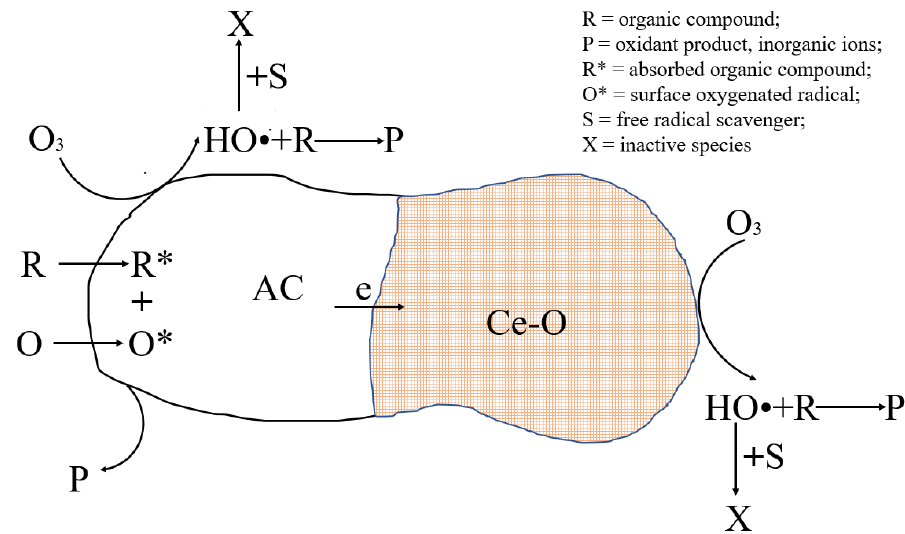
Figure 1. Illustrative representation of the main reaction pathways occurring during ozonation cat- alyzed by AC-Ce-O (based on [72]).